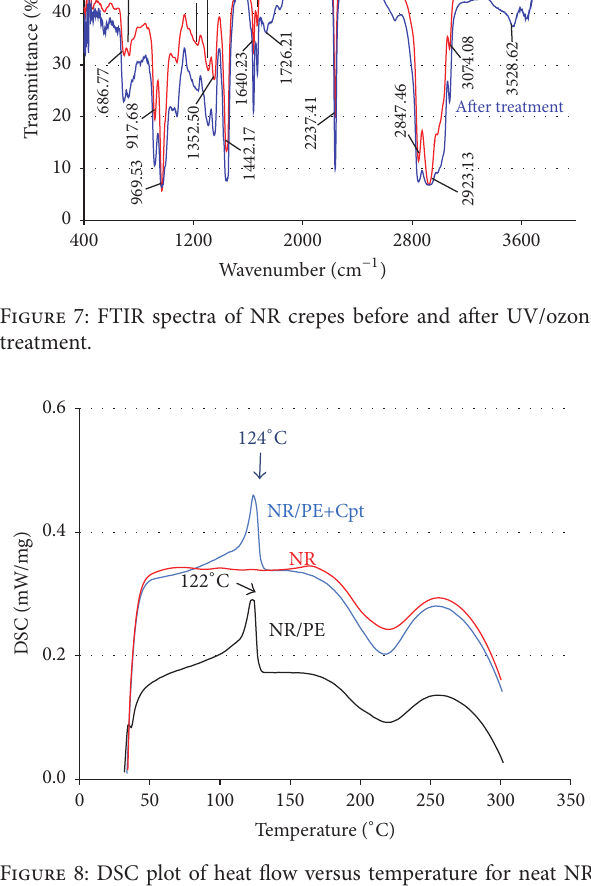
Before treatment